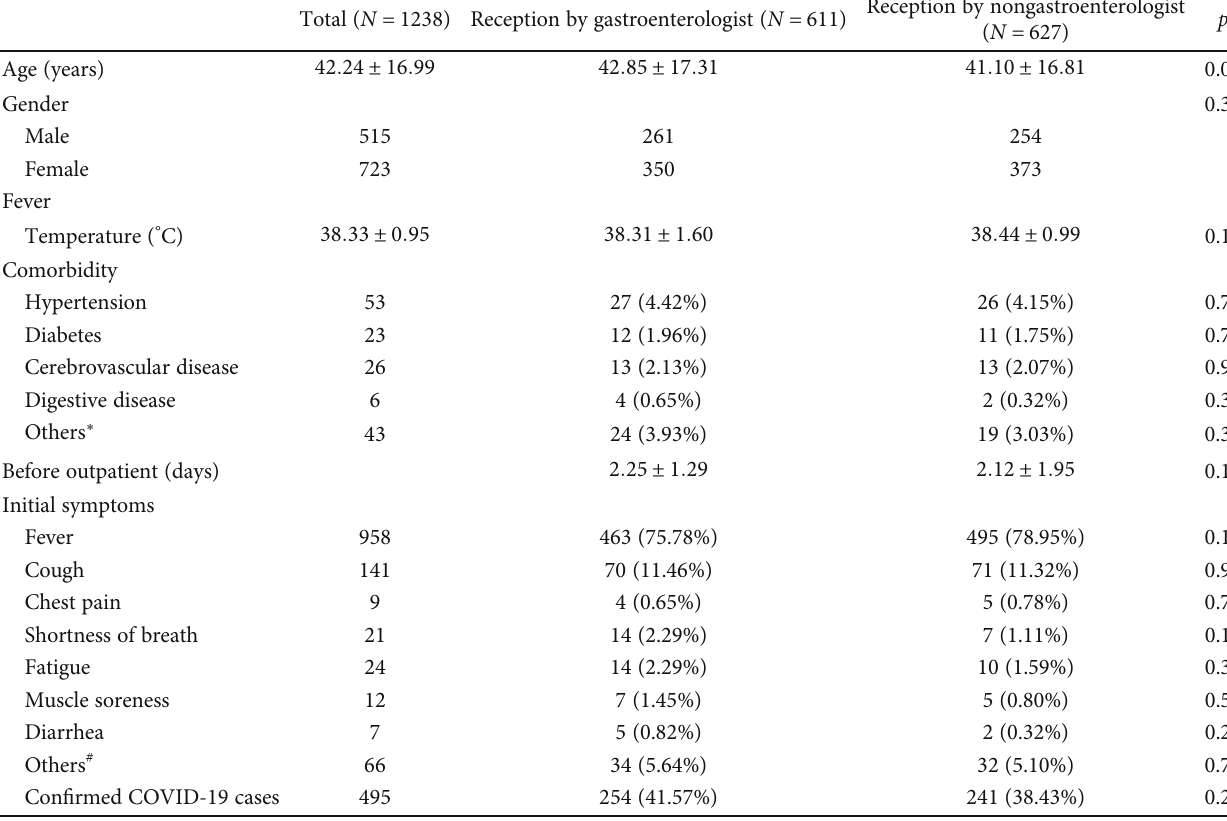
Table 1: Baseline characteristics of included COVID-19 patients based on the classi fi cation of di ff erent outpatient